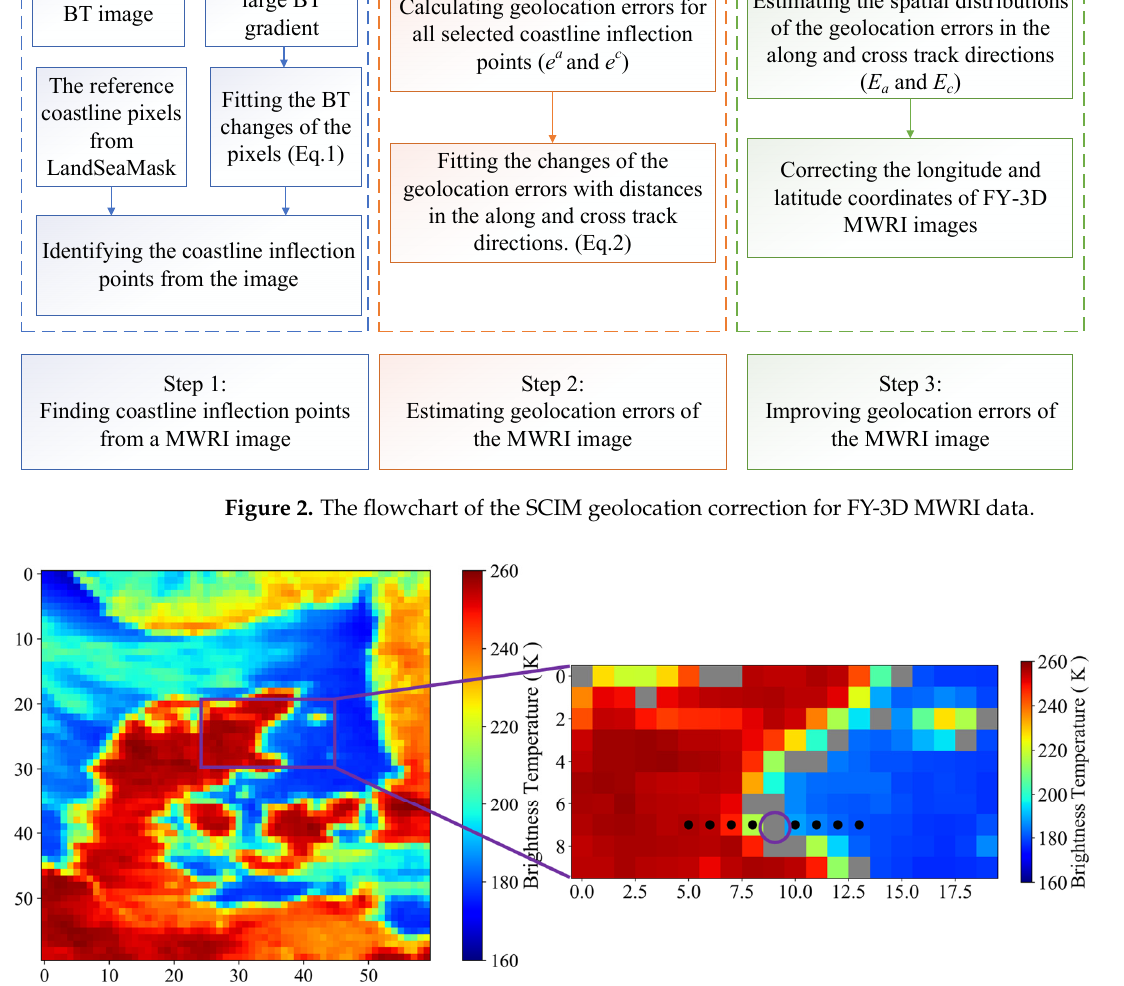
Figure 3. The distribution of FY-3D MWRI brightness temperature of Denmark ( a ) acquired on 3 March 2018. ( b ) shows a zoom area in Aalborg Bugt, Denmark overlaid with the coastline point data. The highlighted gray pixels ( b ) represent the locations of the coastline pixels from LandSeaMask. The data are displayed in the swath coordinate system.